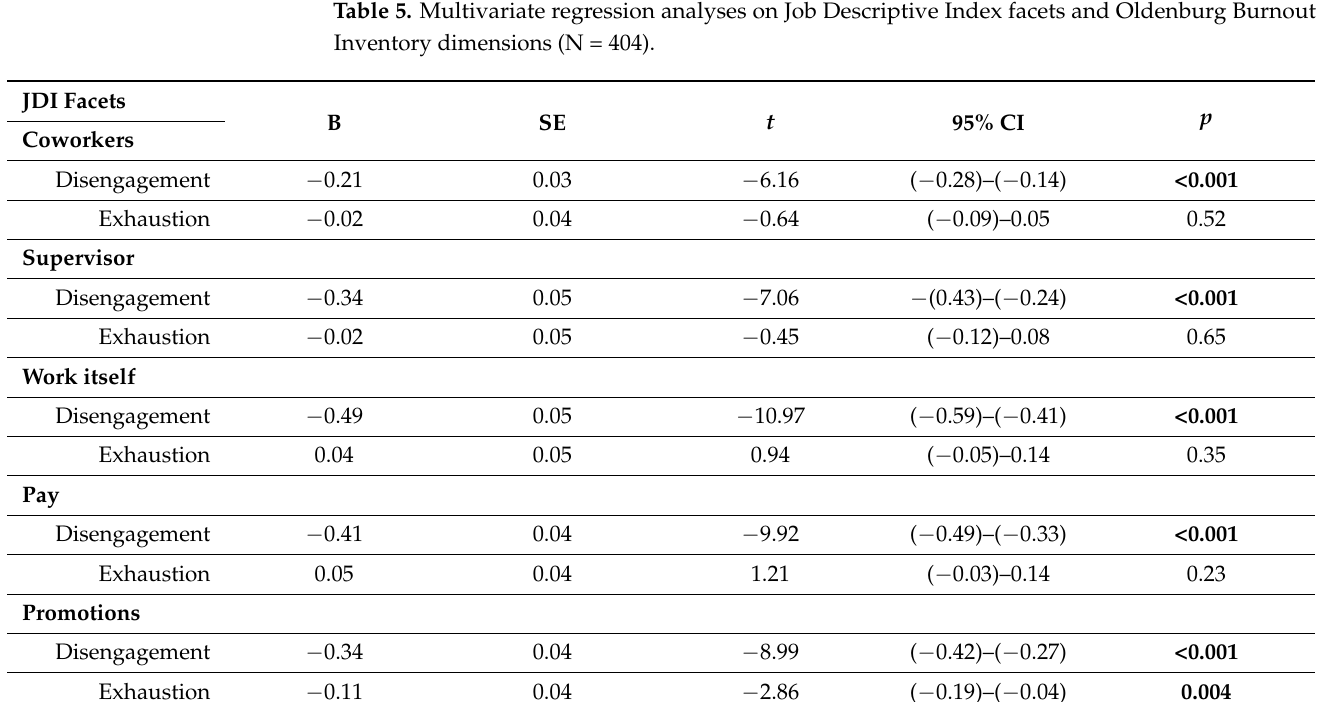
Table 5. Multivariate regression analyses on Job Descriptive Index facets and Oldenburg Burnout Inventory dimensions (N =